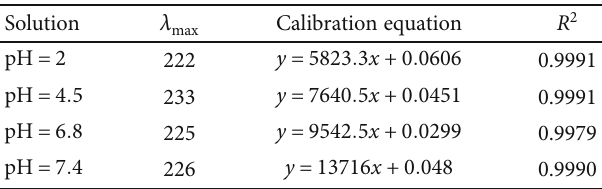
Table 4: Calibration equation and linear coe ffi cient of regression ( R 2 ) of PP in the di ff erent pH